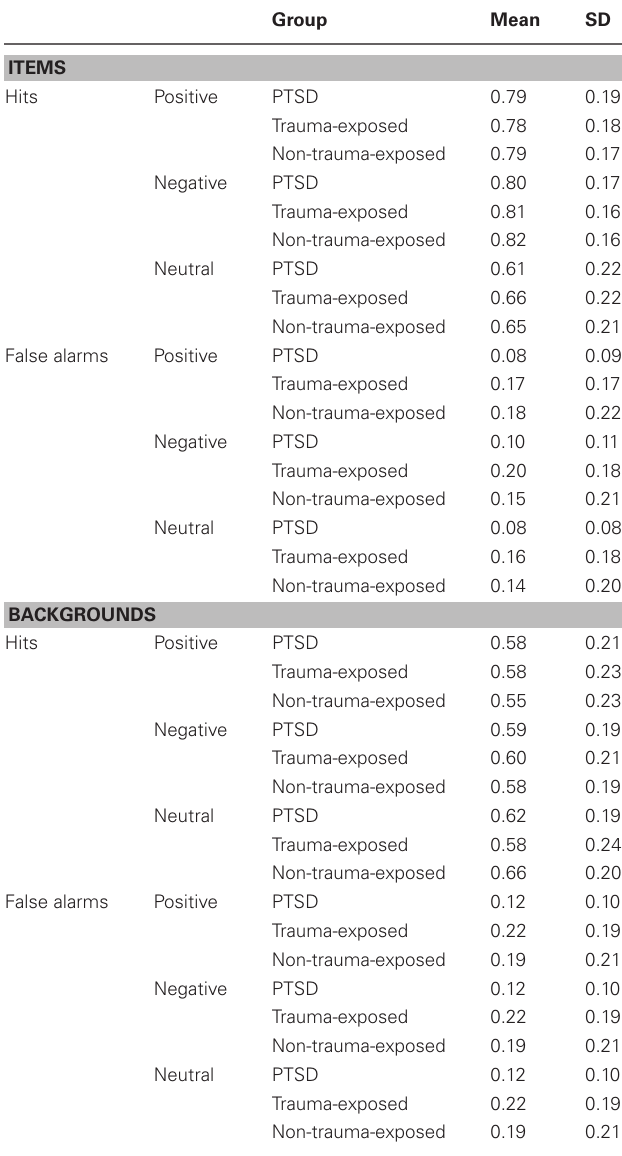
Table 3 | Hits and false alarms for item and background memory for each group and each